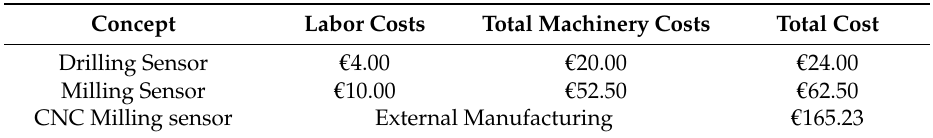
Table 8. Manufacturing costs per machine